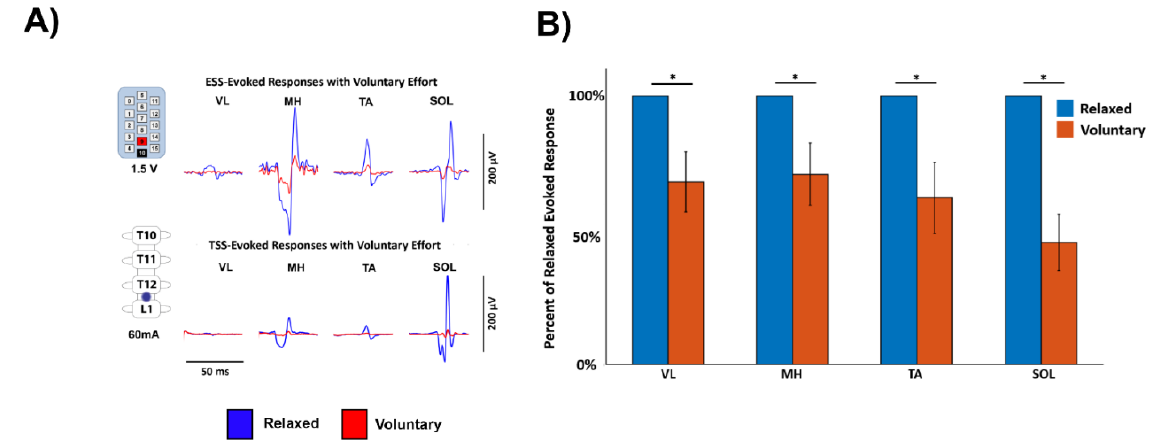
Figure 2. Inhibition of Evoked Response Amplitude During Voluntary Flexion. ( A ). Data from a representative study participant using ESS and a representative study participant using TSS while relaxed and while attempting maximum voluntary flexion of the lower extremities, which results in a decreased evoked response. Stimulation is delivered at the beginning of each trace. Blue indicates the relaxed condition and red indicates the voluntary flexion condition. ( B ). Grouped data from all participants within this study indicating significant decreases across all four recorded muscles when the voluntary flexion condition is compared to the relaxed condition. Data are normalized to the maximum EMG response in each muscle in each participant to compare across participants. Error bars represent the mean ± standard error. VL—vastus lateralis, MH—medial hamstrings, TA—tibialis anterior, SOL—soleus, µ V—microvolt, V—Volt, mA—milliamp, and *—<0.05.